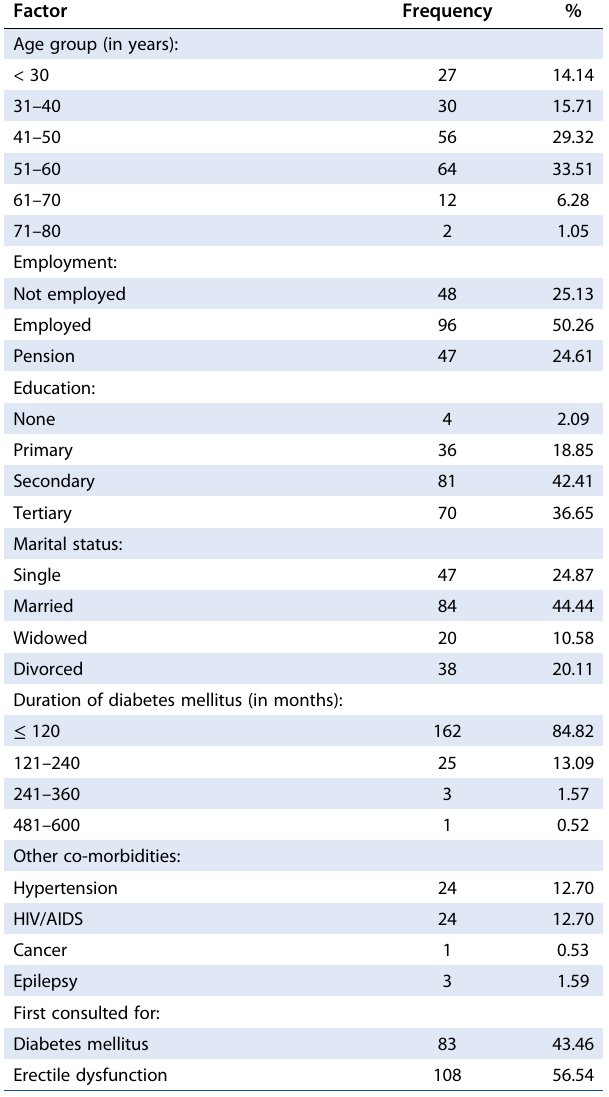
Table 1: Demographic